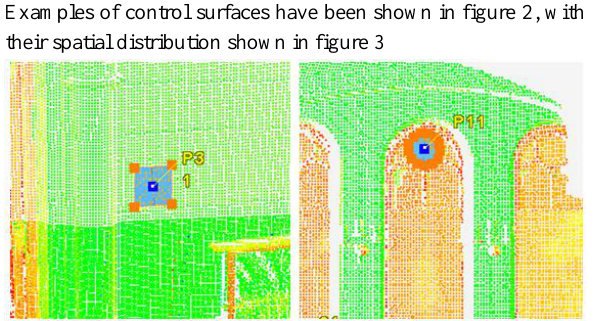
Figure 2. Example of rectangular and circular control surfaces.